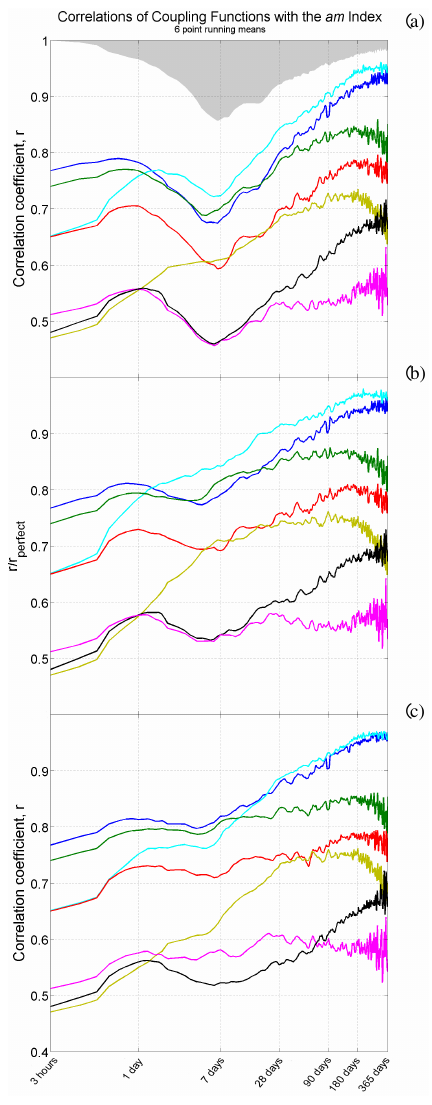
Fig. 9. Correlations between the am index and a number of coupling functions illustrating the effect of data gaps. Correlations are evalu- ated every 3h for averaging periods of 3h to 2 days, every 12h for averaging periods from 2 days to 10 days and every 24h for averag- ing periods from 10 days to 365 days. Point-to-point variability has been reduced using a 6-point smoothing in timescale. From upper to lower: 1. Correlation functions are identical to those shown in Fig. 7, aside from the mentioned smoothing (i.e. for coincident OMNI 2 data to all am data). The lines use the same colour coding as Fig. 7. The grey area is r perfect and cannot be ex- ceeded by even a perfect coupling function because of data gaps. 2. Correlation functions in (a) divided by r perfect . 3. Correlation coefficients between the OMNI data and the am w